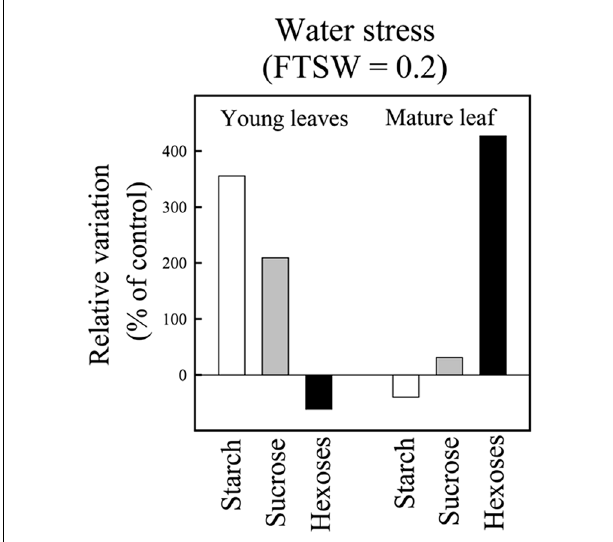
FIGURE 2 | Non-structural carbohydrate concentration in mature and young juvenile leaves at the end of the greenhouse experiment on IR64 genotype. At the end of the experiment FTSW values reached 0.2 for the water stress plants. Each bar represents the relative variation in NSC concentrations of water stressed vs control plants.The mature leaf corresponds to the last fully expanded leaf on the main stem and the young leaves correspond to the pale green hidden expanding leaves on the main stem (adapted from Luquet etal.,